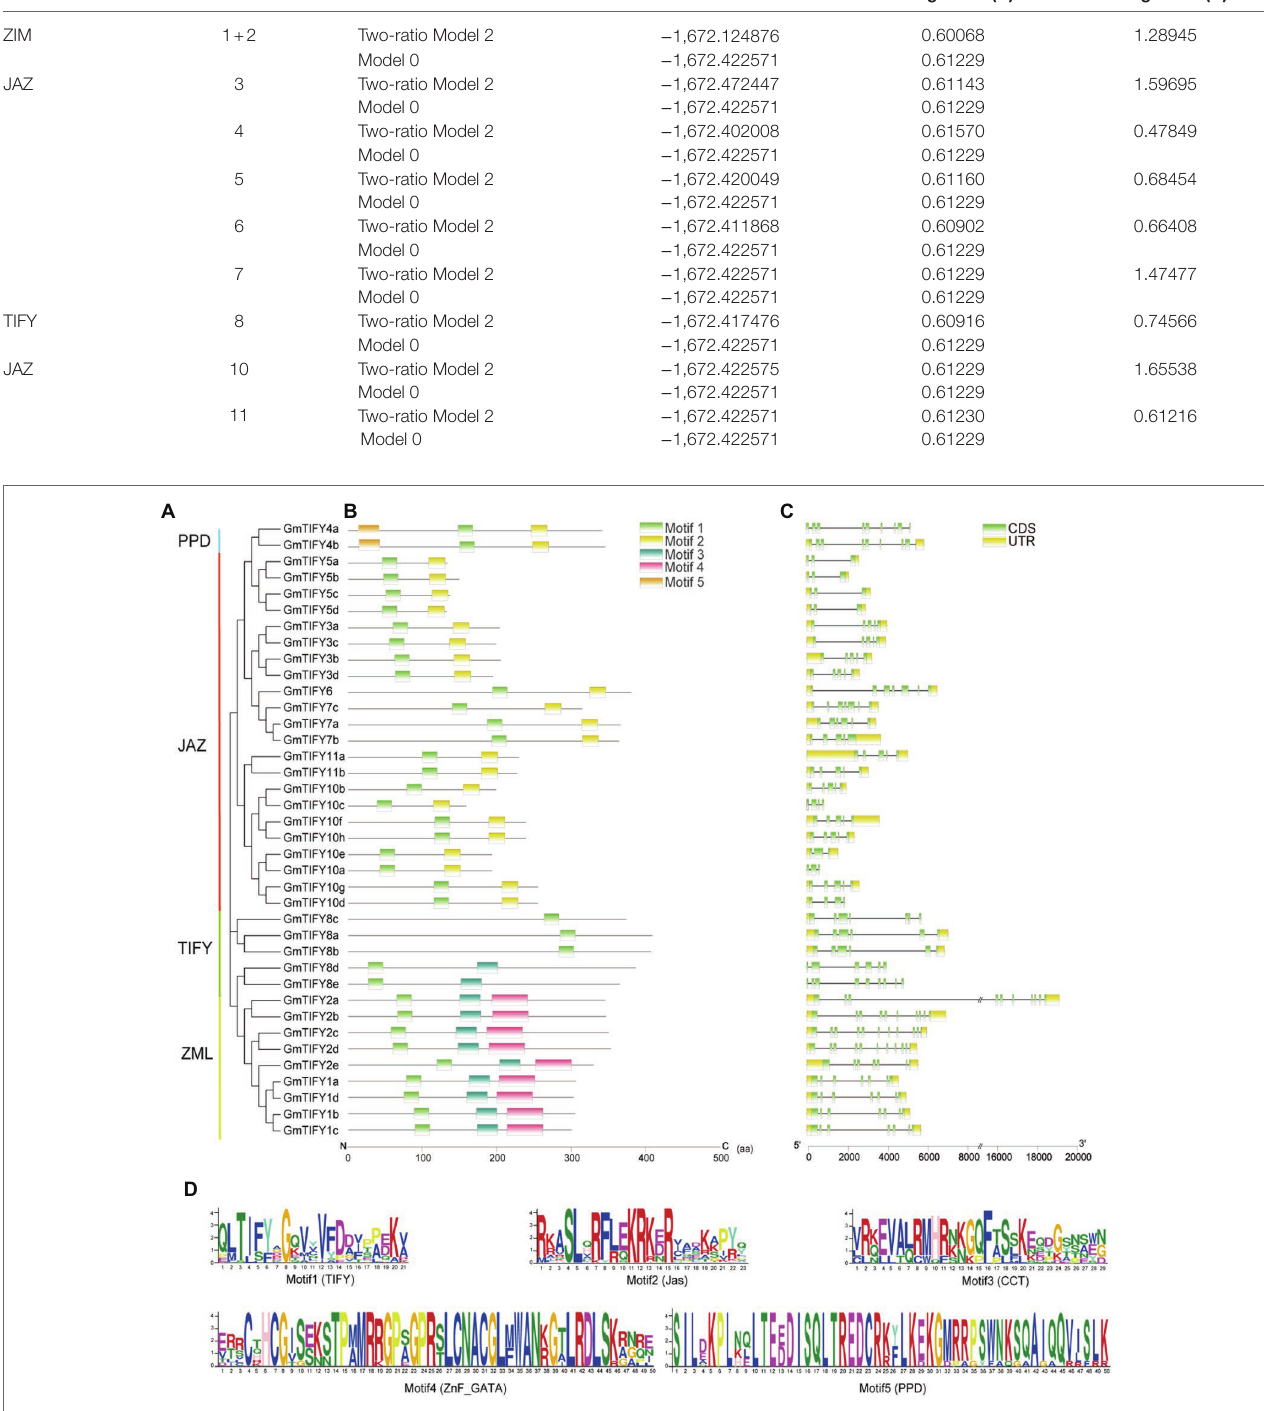
FIGURE 4 | Phylogenetic relationships, conserved motifs, and gene structures of GmTIFY. (A) Phylogenetic tree of TIFY proteins from soybean constructed using the ML method. (B) Distribution of conserved motifs in GmTIFY proteins. Five putative motifs are indicated by colored boxes. (C) Exon/intron organization of GmTIFY genes. Green boxes represent exons and black lines represent introns. The upstream/downstream regions of GmTIFY genes are indicated by yellow boxes. The scale at the bottom is used to infer exons length. (D) Motif logos of five conservative motifs detected in GmTIFY proteins via MEME analysis.